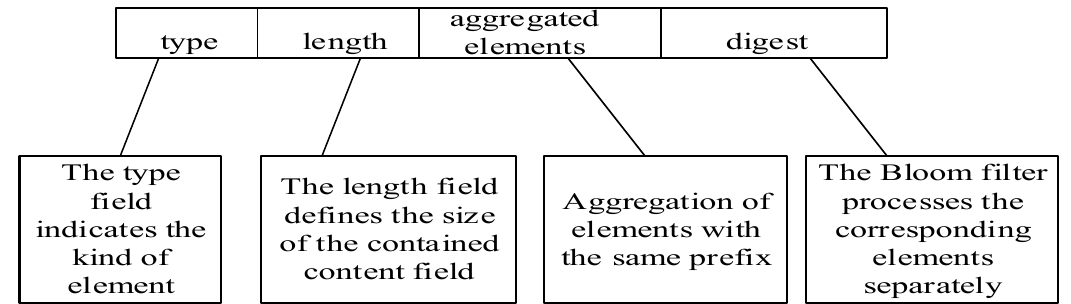
Figure 3. The format of digest type-length-content (TLC).